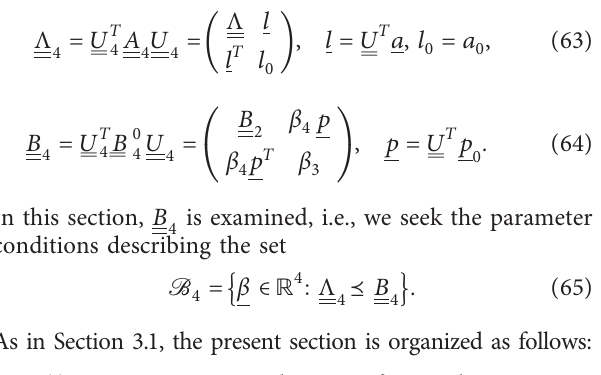
Figure 7: The gray region indicates the admissible domain B A set of 10 random matrices of dimension 100. Individual lines ( β ) values for each represent β min 1 2